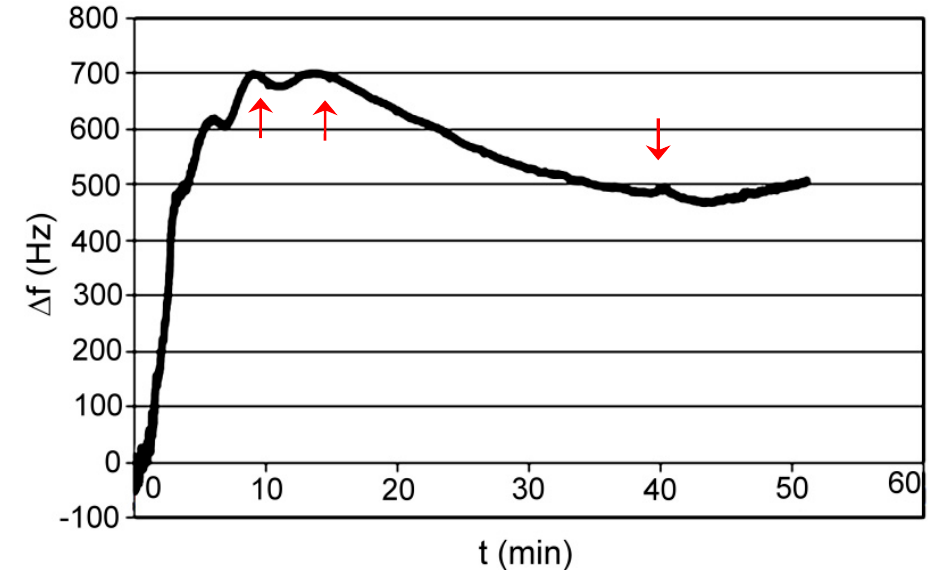
Figure 15. Changes of frequency in time for XVI polymer; absorbed compound—acetylsalicylic acid in acetonitrile.